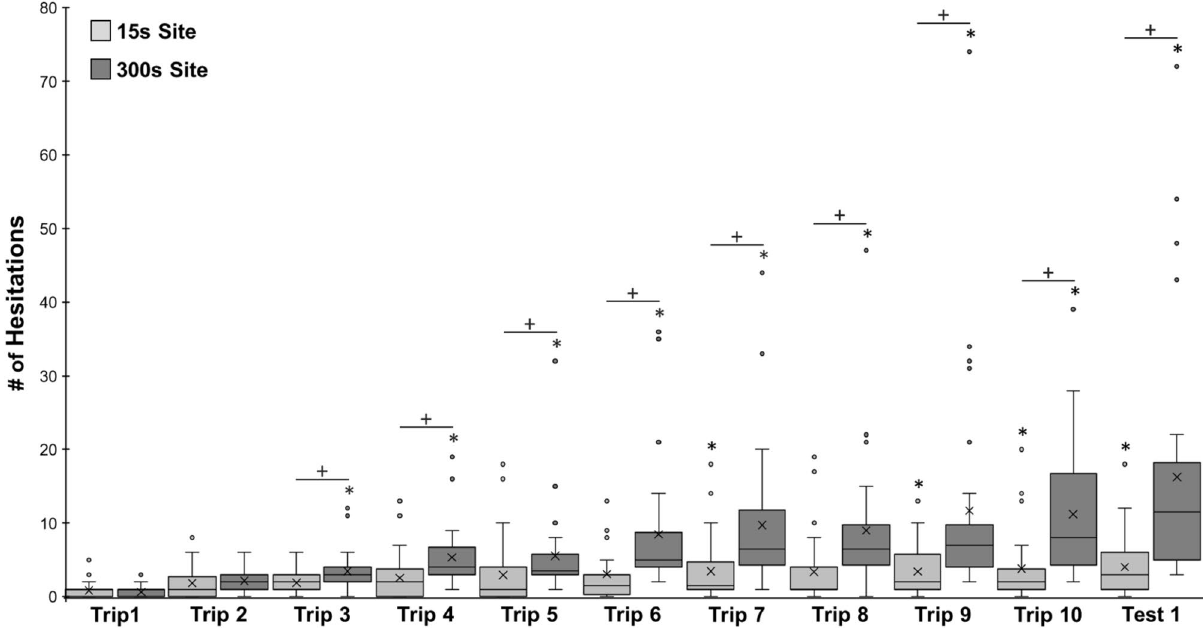
Figure 5. Forager hesitations during training Trips 1–10 and the zero vector test during Hold Duration tests. During training, foragers were collected at both Site 1 and Site 2 and held for either 15 s or 300 s before being released back at the site (hold periods for each site were randomly assigned at the onset of training for each individual). After training Trip 10, foragers were collected at the nest and tested as a ‘zero vector’ forager. During the test, foragers were allowed to travel through Site 1 and Site 2 without collection. Box plots show the median hesitations, consisting of scans and stops, across training and testing (middle line), mean hesitations (×) and 25th and 75th percentile (box) while the whiskers extend to min and max values (excluding outliers). Outliers were defined as values 150% of the IQR beyond 25th and 75th percentile and represented as individual points. Each *denotes training or test trips where foragers’ hesitation numbers were significantly above the Trip 1 baseline (p < 0.05). Each ‘+’ denotes trips in which the forager showed significantly higher hesitation numbers leading up to the 300 s collection site compared to the 15 s site (p <